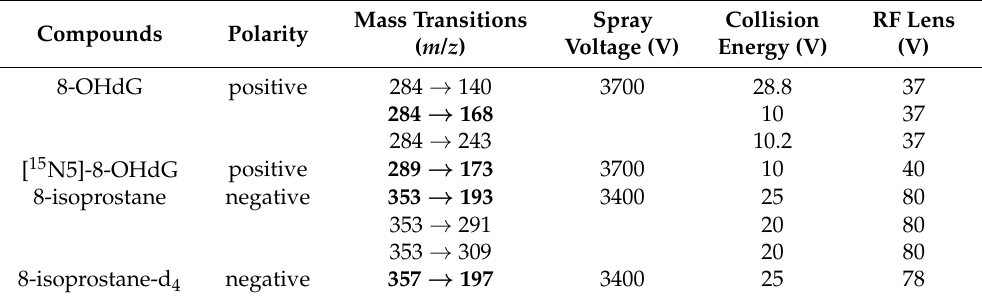
8-isoprostane-d 4